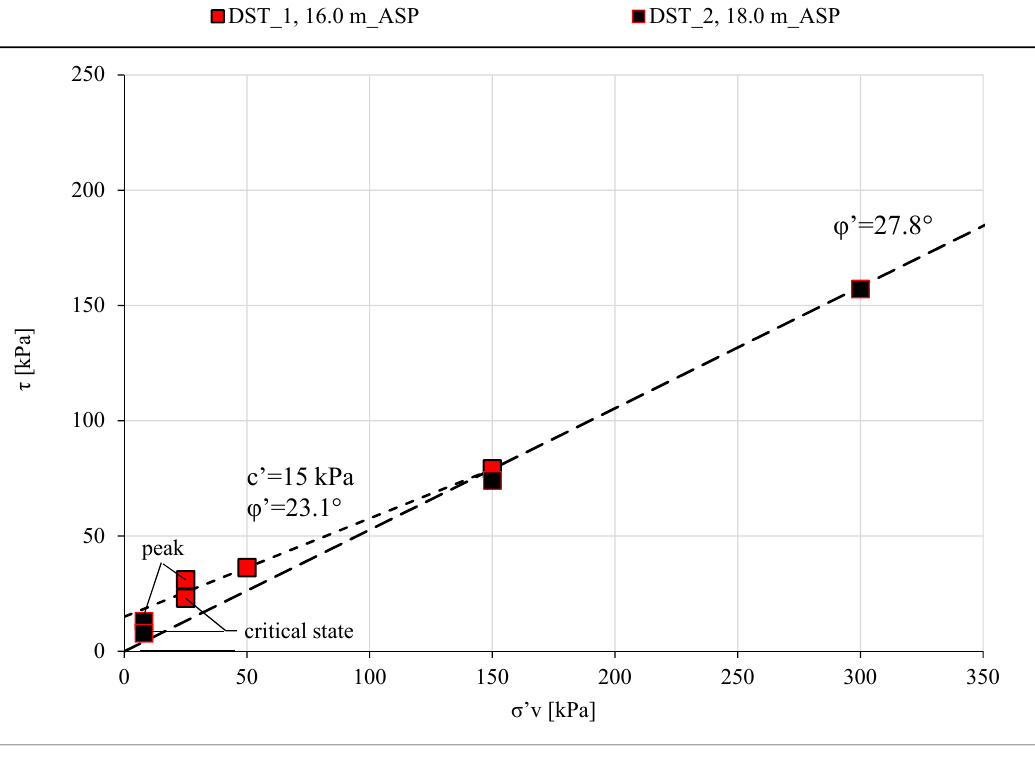
Figure 9. Strength envelopes of the Mar Piccolo (MP) deep sediments obtained by direct shear tests.